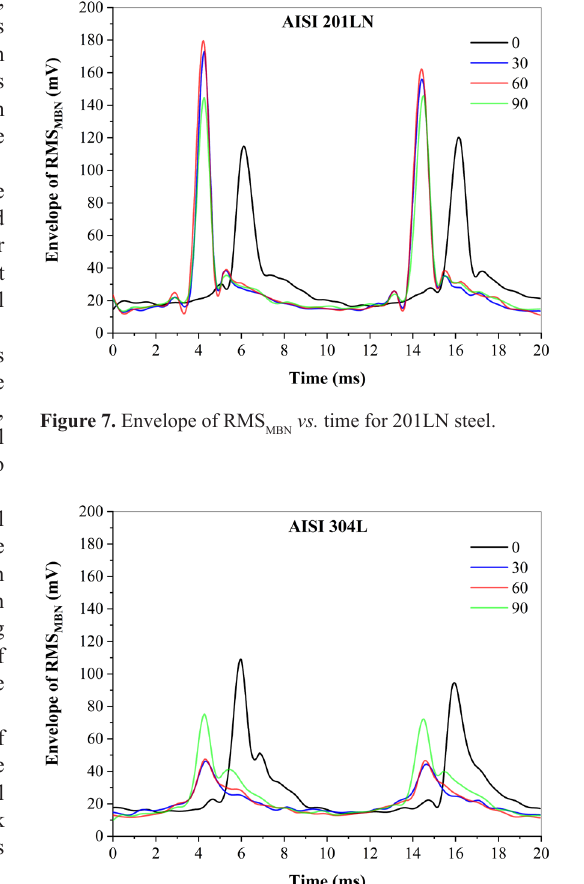
Figure 8. Envelope of RMS